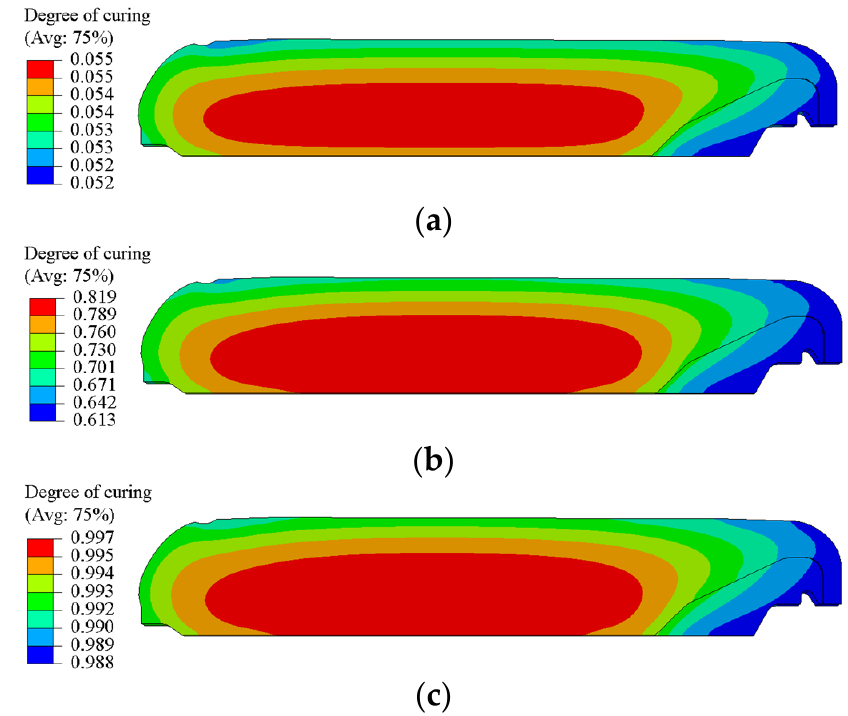
Figure 6. Contours of the curing degree. ( a ) 24 h . ( b ) 72 h . ( c ) 168 h .